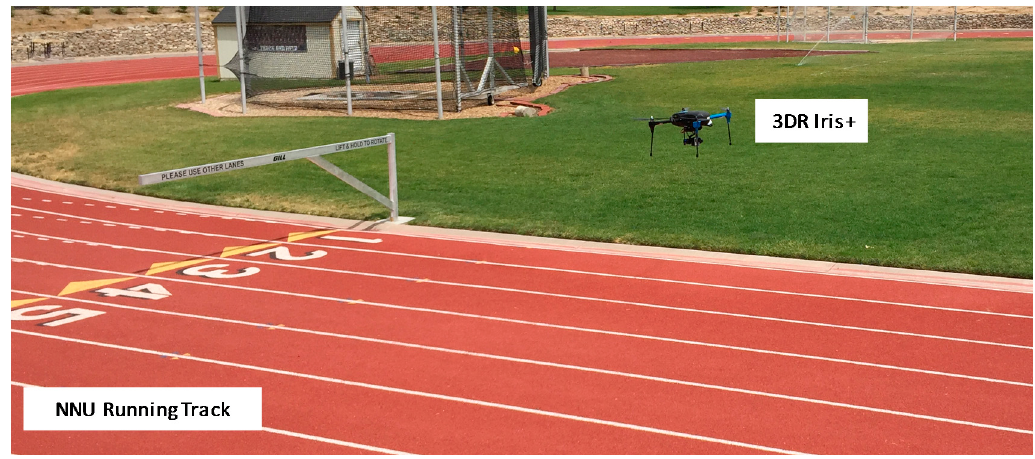
Figure 4. Rectilinear motion test for the 3DR Iris+.